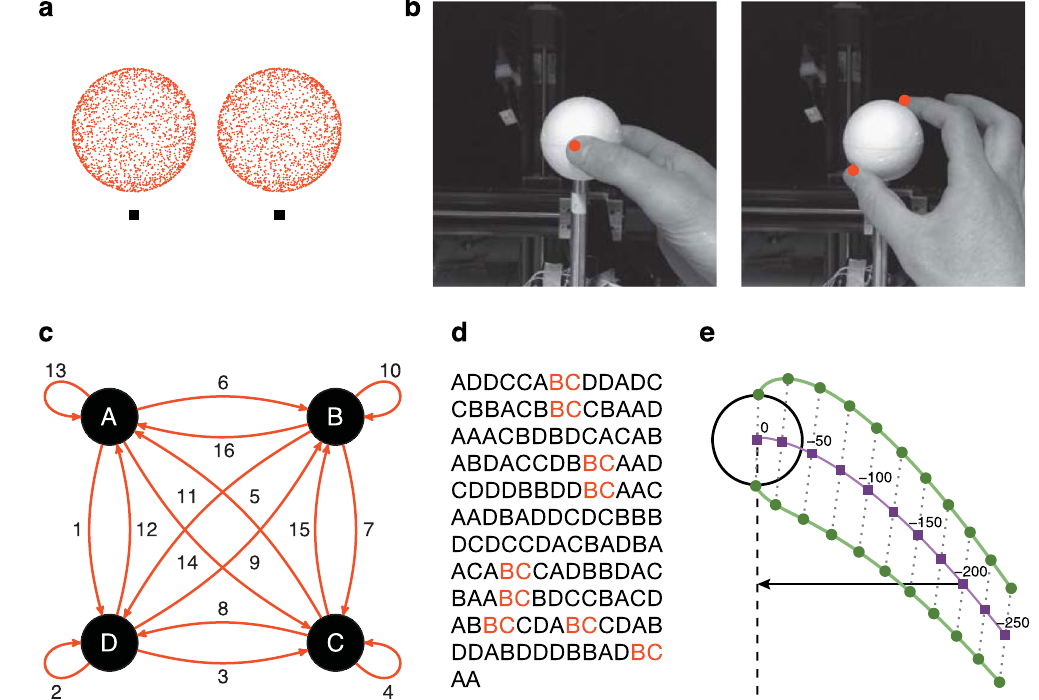
Figure 6. Methods. ( a ) The three-dimensional structure of the stimulus can be observed by cross-fusing the two images stereoscopically. ( b ) Grasping along the depth axis (left image) and along the oblique axis (right image). Participants never had full vision of the hand, only visual feedback about the fingertips was provided (red dots). ( c ) A de Bruijn graph for n = 2 and a four-character alphabet composed of the characters A, B, C, and D which represent the four object’s distances. Following the numbered edges in order from 1 to 16 traces an Eulerian cycle AD, DD, DC, CC, CA, AB, BC, CD, DB, BB, BD, DA, AA, AC, CB, BA. By appending the first element to the tail and by taking the first character of each of these elements we obtain the de Bruijn sequence ADDCCABCDBBDAACBA without repetitions. ( d ) An example of a 145-long de Bruijn sequence with the repetition factor set to r = 3. Each of the two-character elements is repeated 9 times. ( e ) The green lines represent the thumb and index digit trajectories when grasping the sphere along the depth axis. The purple line represents the last 250 mm of the movement path of the midpoint between the fingertip positions. The values above the purple line show the distances from movement end along the path. The projection of the purple line (arrow) on the sagittal axis (dashed line) represents the hand position at a given point of the movement path. The dotted lines connect the thumb and index digit when both were at the same point of the movement path. The length of the dotted lines thus corresponds to the grip